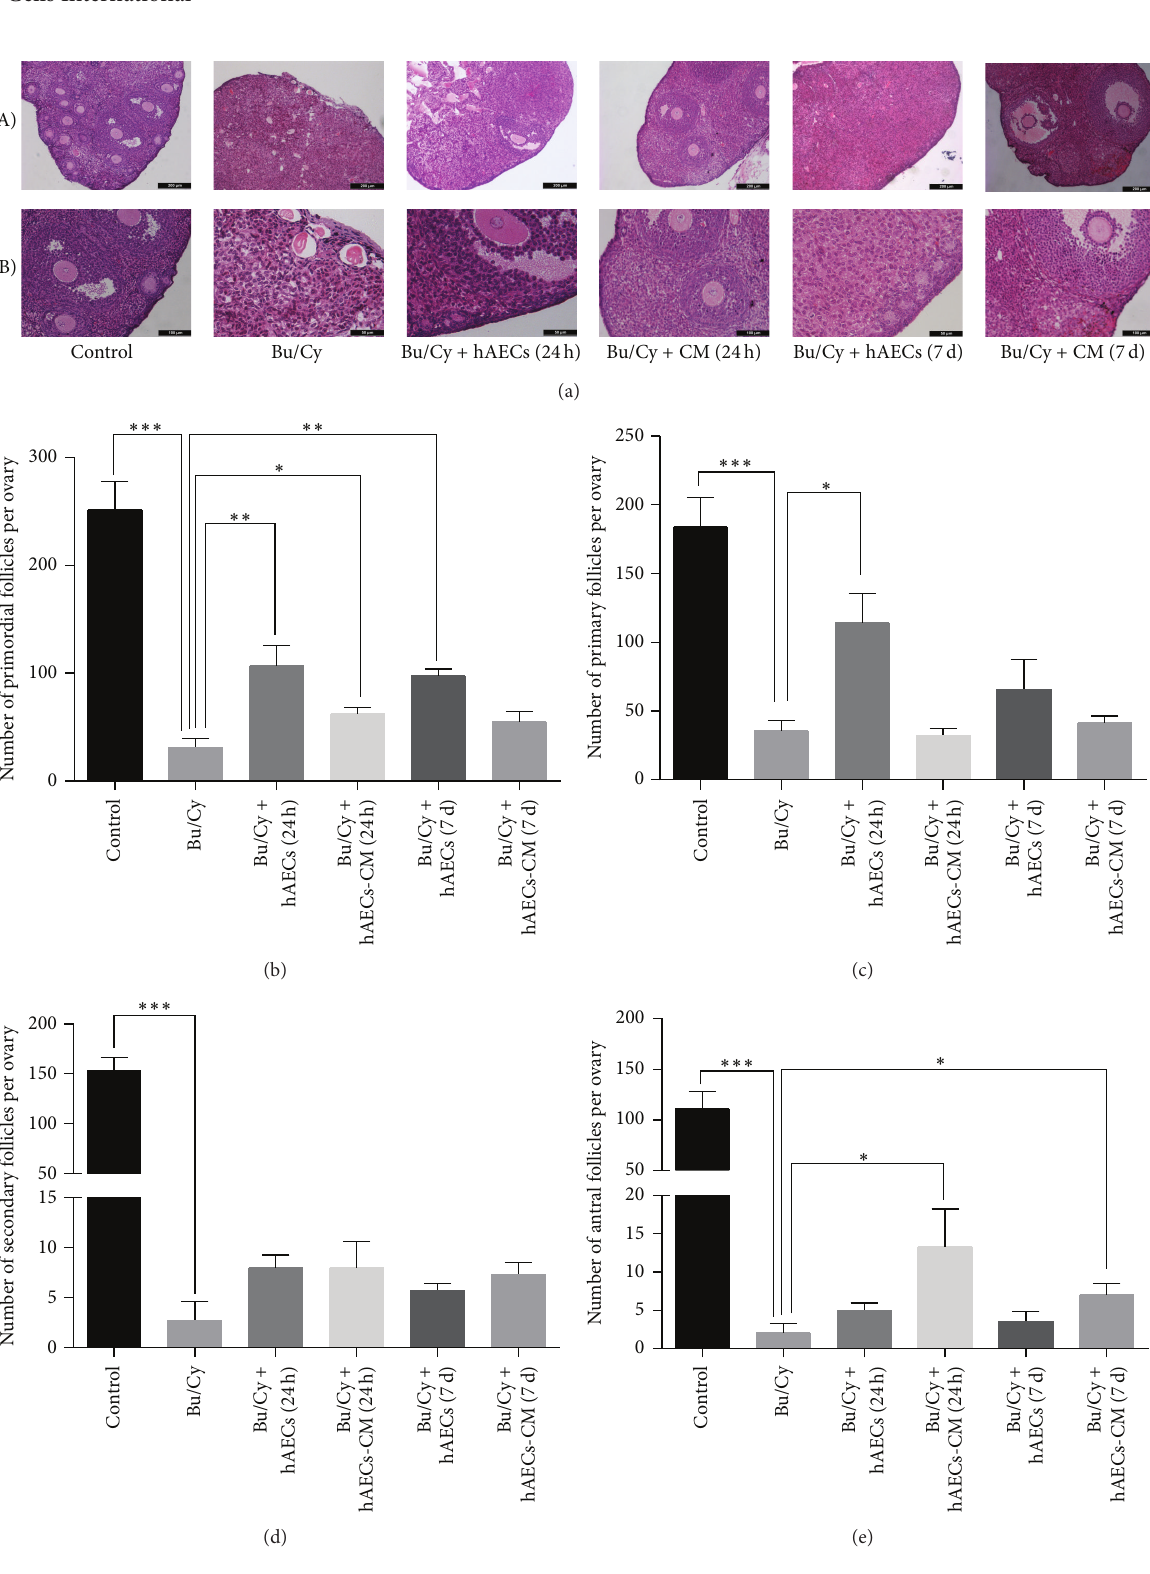
Figure 3: Histological analysis of mice ovaries and the follicle number count after treatment with hAECs or hAECs-CM. (a) Ovary tissues from each group were stained with hematoxylin and eosin. Numbers of oocyte-containing follicles at all stages were classified and counted in every fifth section. The primordial follicles (b), primary follicles (c), secondary follicles (d), and antral follicles (e) were identified and calculated. Data are shown as mean ± SEM, ∗ 𝑃 < 0.05 , ∗∗ 𝑃 < 0.01 , ∗∗∗ 𝑃 < 0.001 . Scale bar: 200 𝜇 m (Panels (a)(A)) and 50 𝜇 m (Panels (a)(B)),